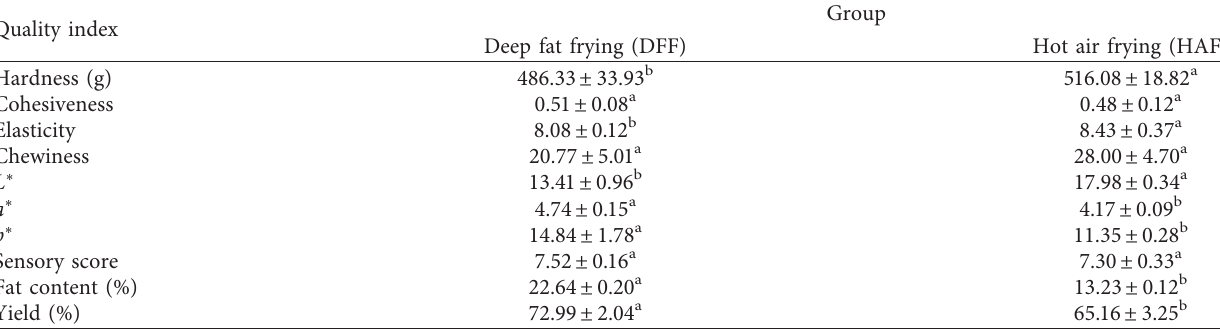
Figure 1: Appearance photo of giant salamander meatballs by deep fat frying and hot air frying. Table 1: Texture, color, sensory scores, fat content, and yield of giant salamander meatballs after two frying methods.